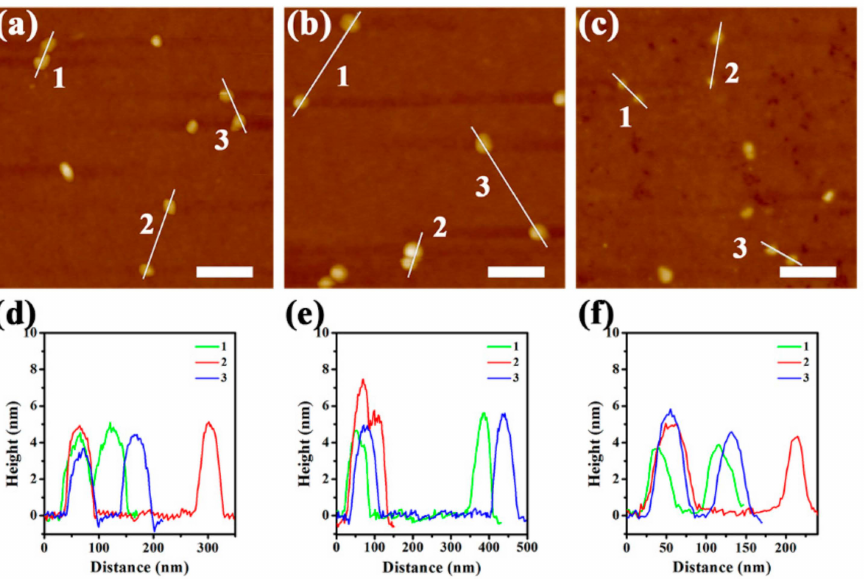
Figure 5. AFM images and corresponding height profiles of MoS 2 , MoSe 2 , and WS 2 NSs prepared by CMC–assisted ball milling: ( a , d ) MoS 2 , ( b , e ) MoSe 2 , ( c , f ) WS 2 . Scale bar: 200